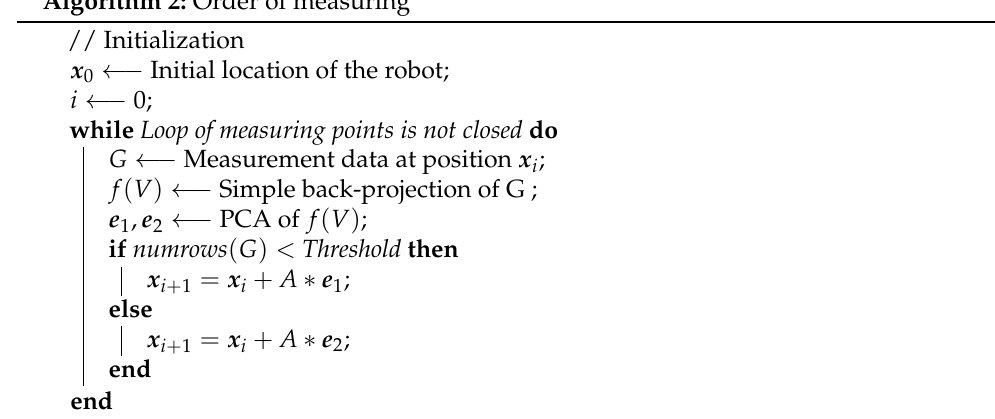
Figure 7. Loop closure of measurement path: the measurement path generation is completed when the loop is closed. Algorithm 2: Order of